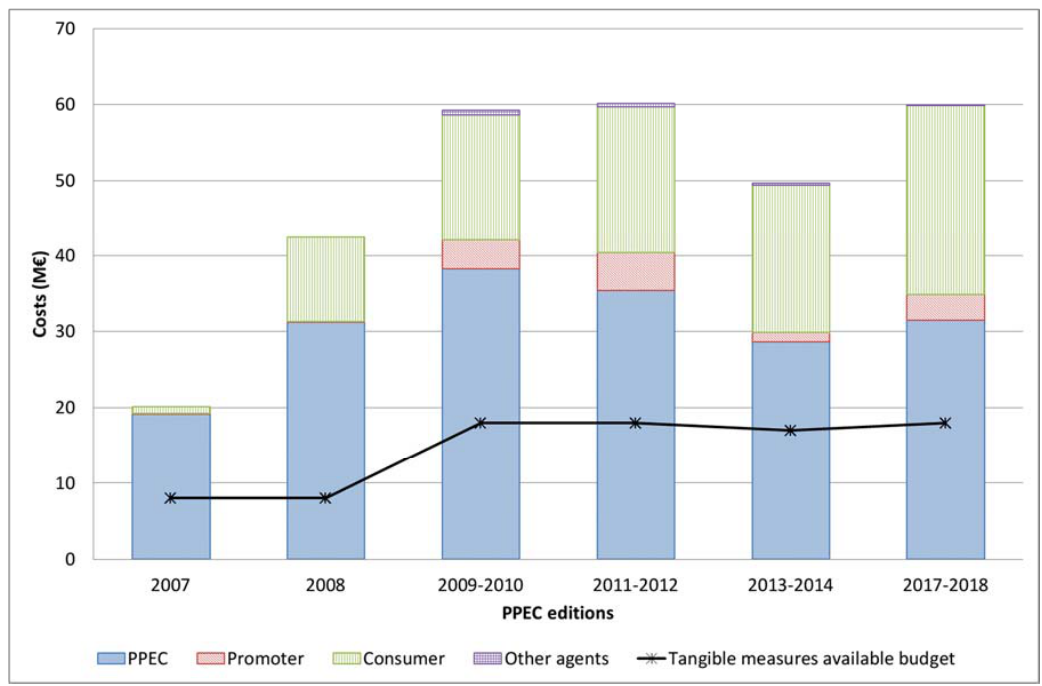
Figure 6. Societal costs of the eligible tangible measures and related available budget [19–25]. Each agent’s average share of the societal costs of eligible measures is presented in Figure 7.